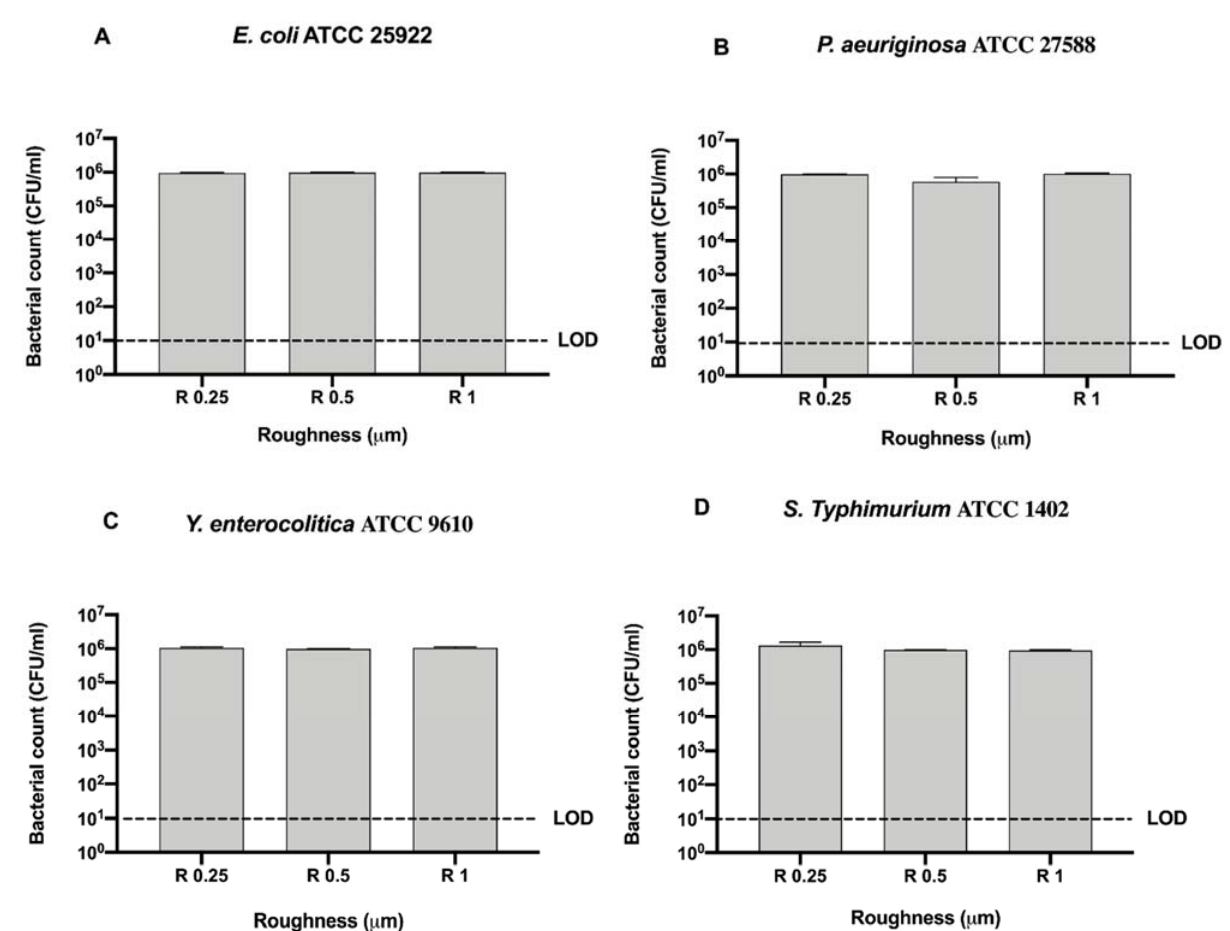
Figure 6. Graphical representation of the antibacterial activity of different AISI 316 stainless steel surface roughness against Gram-negative bacteria ( A–D ); Limit of detection (LOD) is 10 1 (10E+1).